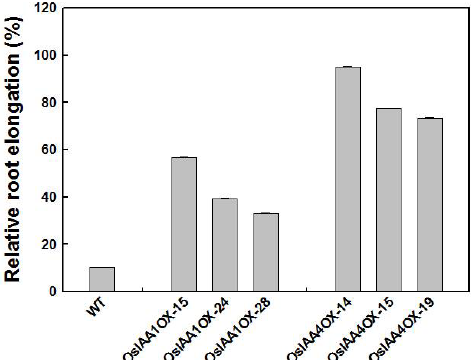
Figure 4. 2,4-D effects on root elongation. Plants were grown in MS medium with or without 0.1 μ M 2, 4-D. Root length was measured after 12 days. Relative root lengths are given as the percentage of root length of untreated plants grown in MS medium without 2,4-D. Error bars indicate SE, n = 20.